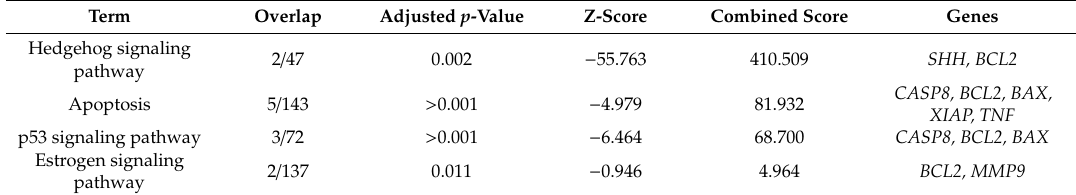
Table 1. Significant enrichment pathway related to breast cancer by targets of cordycepin (adjusted p -value of ≤